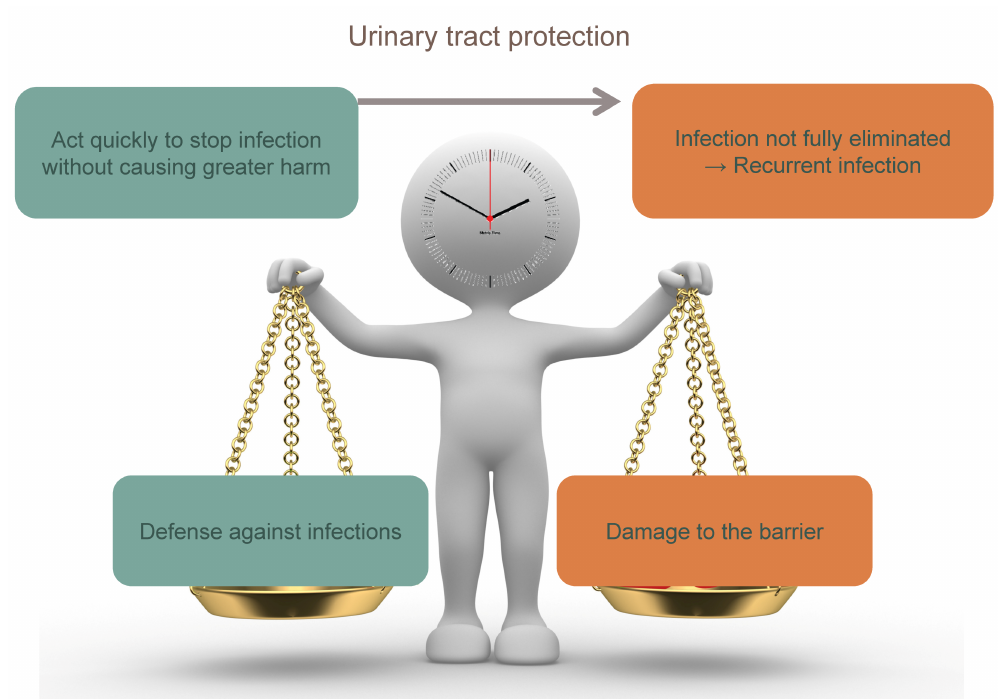
Figure 3: To obtain an adequate urinary tract protection, the immune system must act quickly to stop uropathogen invasion without causing greater harm. If this response is curtailed too soon in order to prevent more damage, infection could not be fully eliminated leading to recurrent